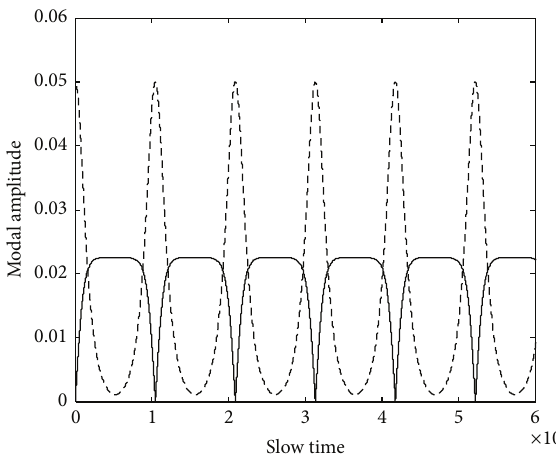
Figure 3: A fixed flexible arm in ADAMS.